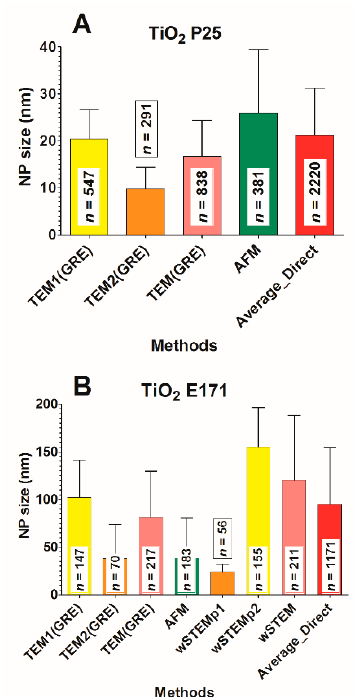
Figure 9. Average size measurements for sub-populations of TiO 2 NPs: ( A ) P25; and ( B ) E171. The larger size populations are colored in yellow, whereas smaller size populations are in orange. Global average of NP sizes within the same technique is colored in pink. The large SD values in AFM data (green columns) prompted checking for the presence of smaller NPs in TEM data by changing the protocol of NPs deposition (TEM1, carbon floatation; and TEM2, direct deposition; see Section 4.3). For both NPs, the TEM2 method identified the presence of smaller NPs than with the TEM1 method, in close agreement with AFM results (which is using a direct deposition method). The global average value of all tested direct techniques is shown in the last column (in red). The two sub-populations observed in wet-STEM were described prior to the change of TEM(GRE) protocol.